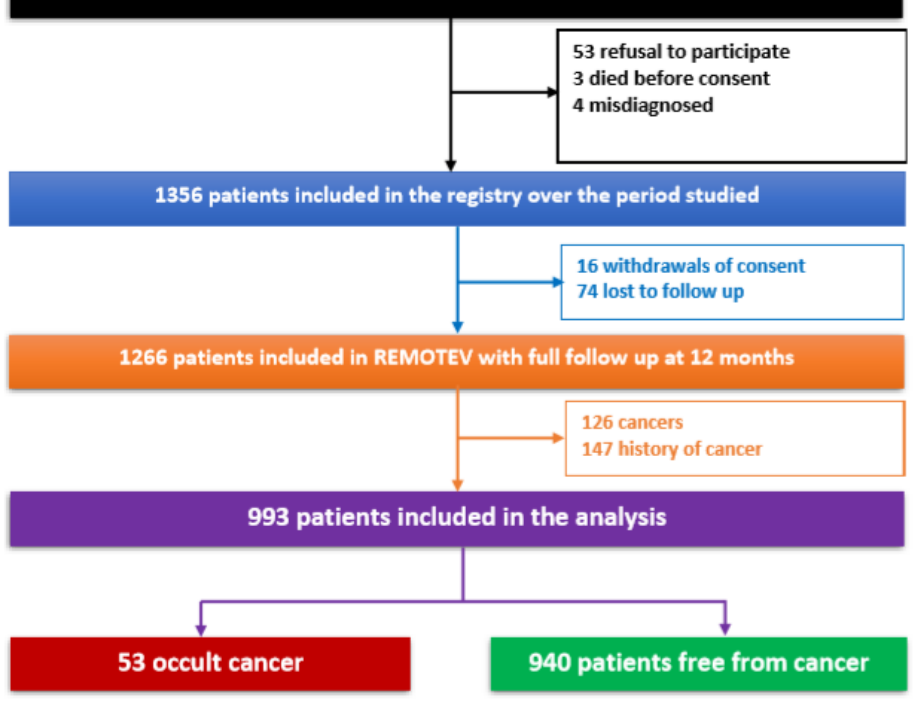
Figure 1. Study flowchart showing patients’ Figure 1. Study fl owchart showing patients’ selection. Table 1. Baseline characteristics according to occult cancer status.